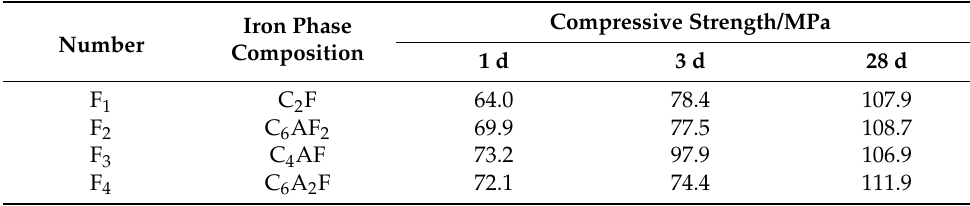
Table 3. The mechanical properties of different samples.